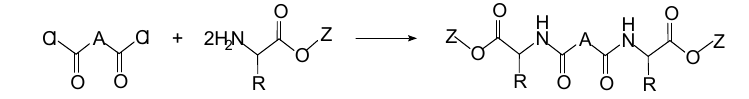
; For R, see Figure 19 3